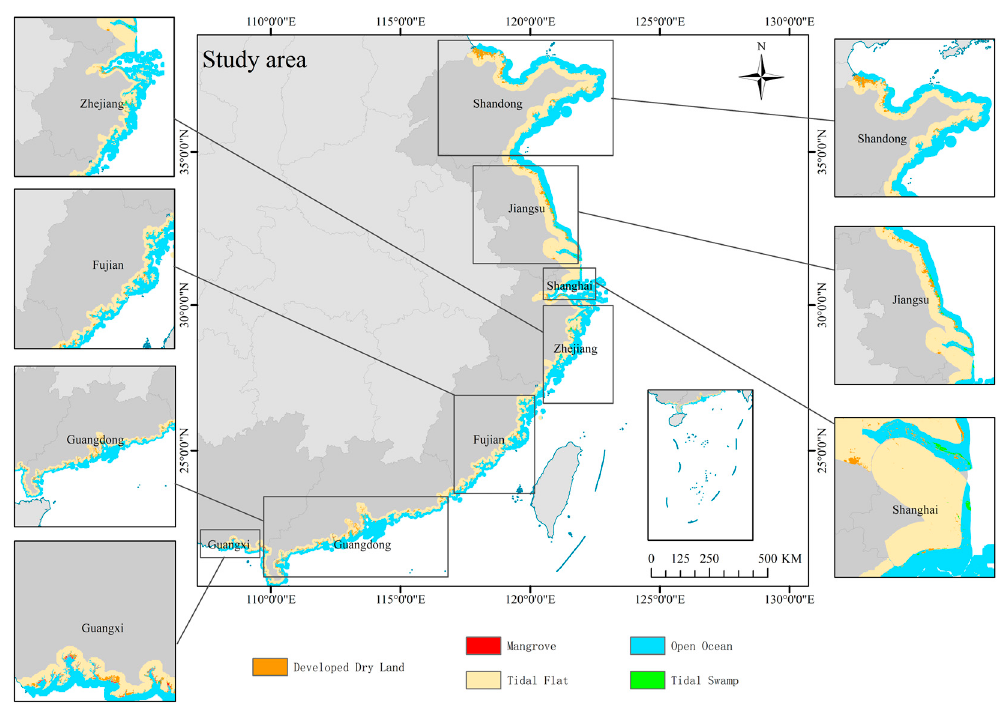
Figure 2. Location of the study area. Table 1. Description of the study areas with their equivalent SLAMM